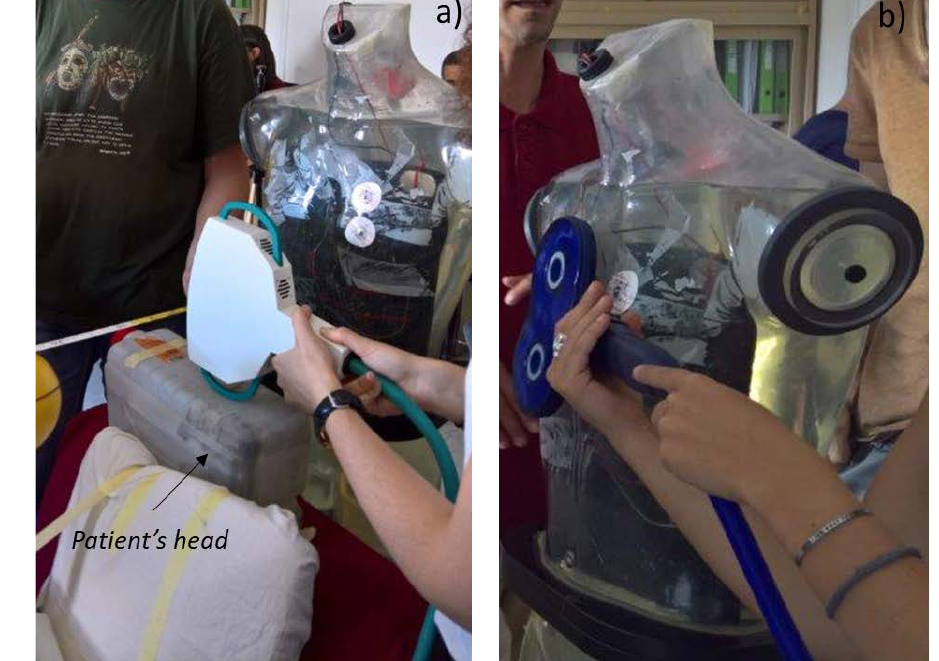
STM900 (ATES Medical Device, Colognola, Italy) and ( b ) the Magstim ® Bstim2 (Magstim Company, Whiteland, UK). In both tests, beside the human torso-shaped phantom that simulates the health-care personnel holding the TMS coil, a tank filled with a saline solution at the same concertation (2 g / L) was adopted to simulate the patient’s